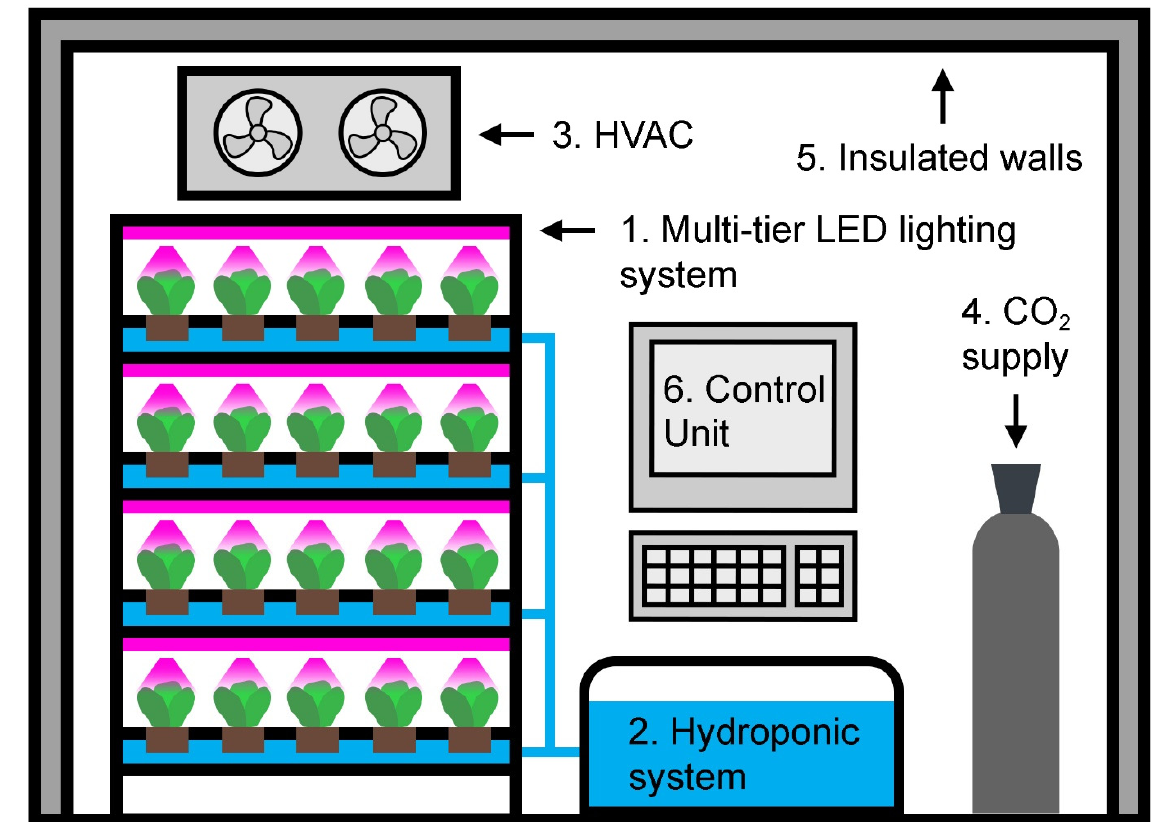
Figure 2. The layout of a vertical farm. (1) A multi-tier system with light-emitting diode (LED) lighting elements; (2) a hydroponic system; (3) a heating, ventilation, and air conditioning (HVAC) unit; (4) CO 2 fertilization; (5) thermally well-insulated and airtight walls; and (6) an environmental (i.e., light, temperature, humidity, CO 2 , and airflow) and nutrient solution (i.e., electrical conductivity (EC), pH, O 2 , root zone temperature) control unit.